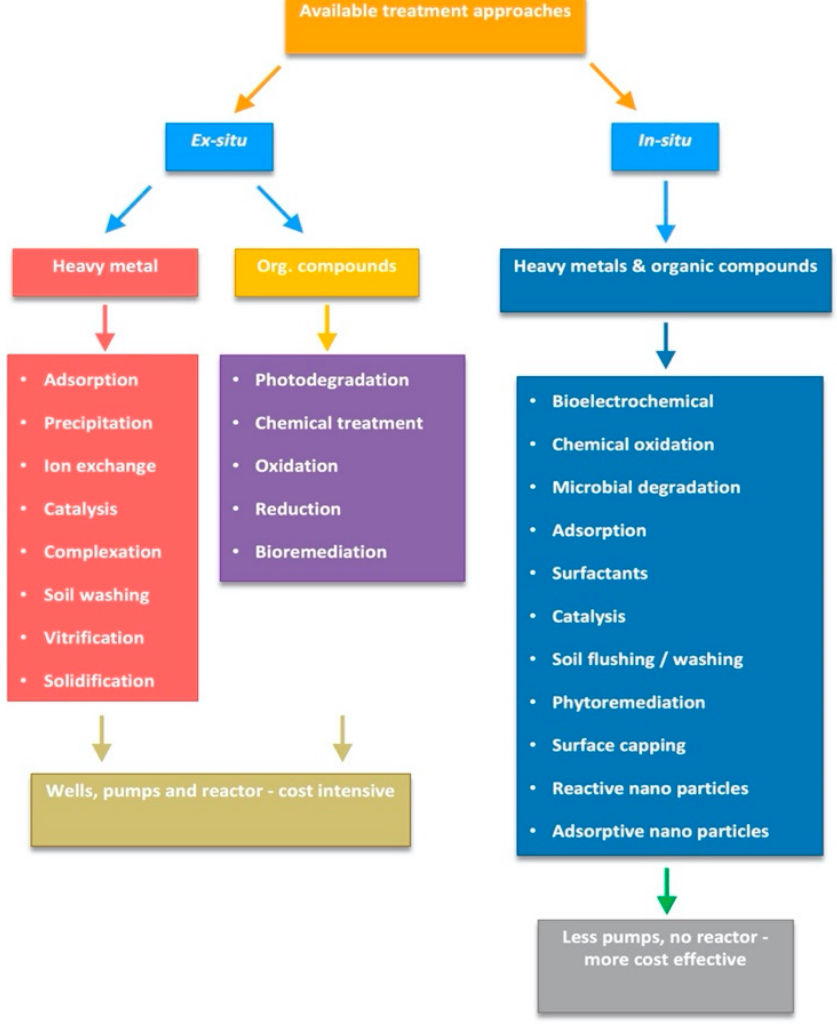
Figure 4. Overview of common ex-situ and in-situ treatment approaches for environmental reme- diation.